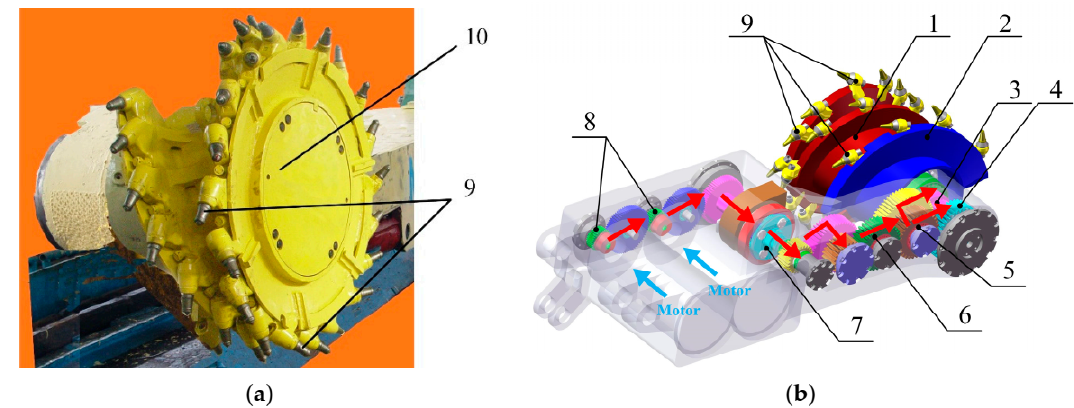
Figure 4. ( a ) Actual shearer drum; ( b ) The ranging arm with two-segment differential rotational speed drum (TDRSD). 1. Front drum; 2. Rear drum; 3. Drive gear of rear drum; 4. Drive gear of front drum; 5. Bearing; 6. Idler wheel; 7. Planetary gear train; 8. Motor gear; 9. Conical pick; 10. Single drum.